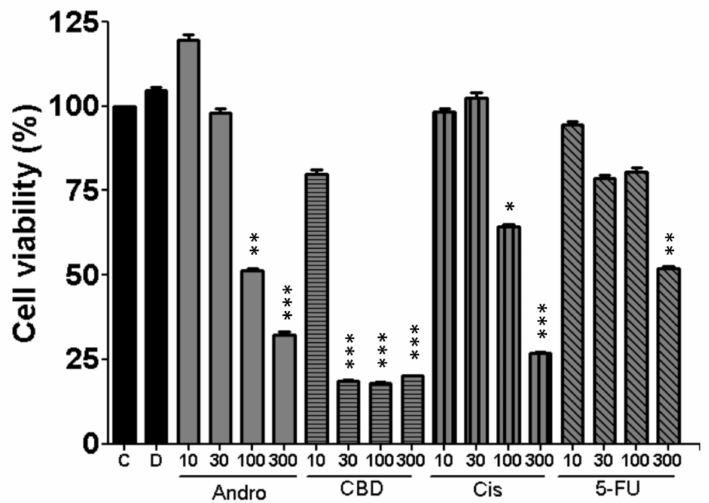
Figure 5. Change of cell viability of SCC-25 cells upon treatments of andrographolide, CBD, cisplatin and 5-FU for 24 h at the indicated concentrations. In each experiment there was a control (C) and cells treated with DMSO (D). Cell viability was evaluated by alamarBlue assay. All treatments at higher concentrations displayed statistically significant reductions relative to the control groups. Five independent experiments were performed (n = 5) and results are shown as mean ± SEM. * p < 0.05, ** p < 0.01, *** p <